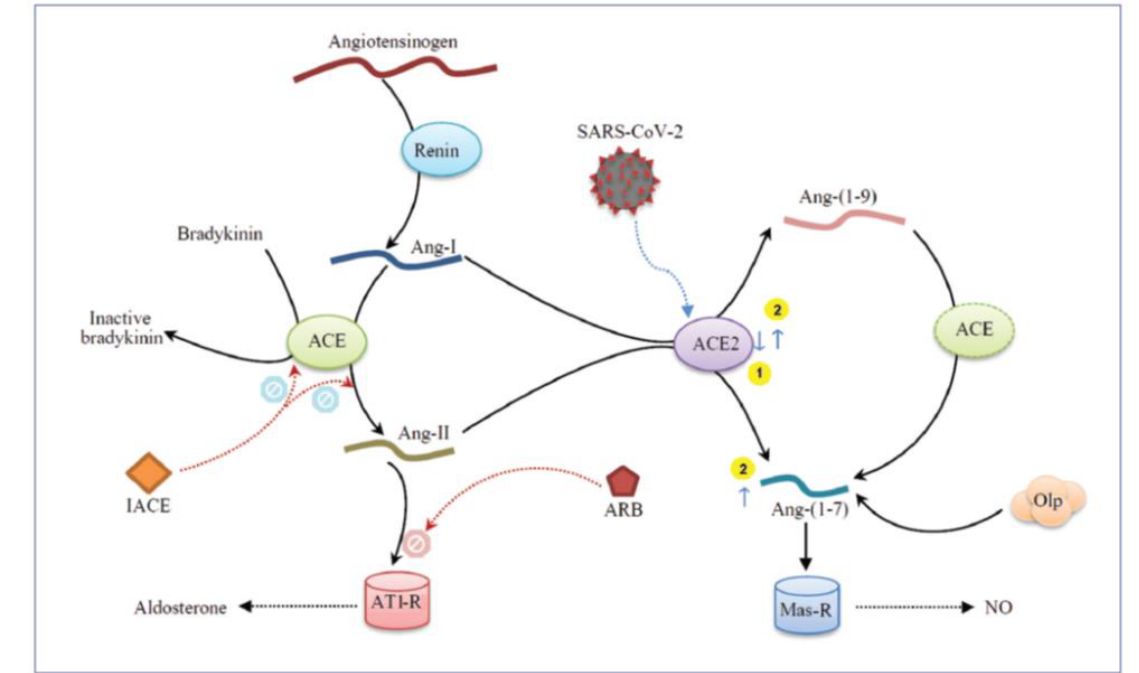
Figure 3. Effect of SARS-CoV-2 on physiological action of Renin-Angiotensin-Aldosterone- System. 1. Reduction of ACE2 during corona virus infection 2. Increase ACE2 and Ang (1-7) after ACE-Is and ARBs administration (74)